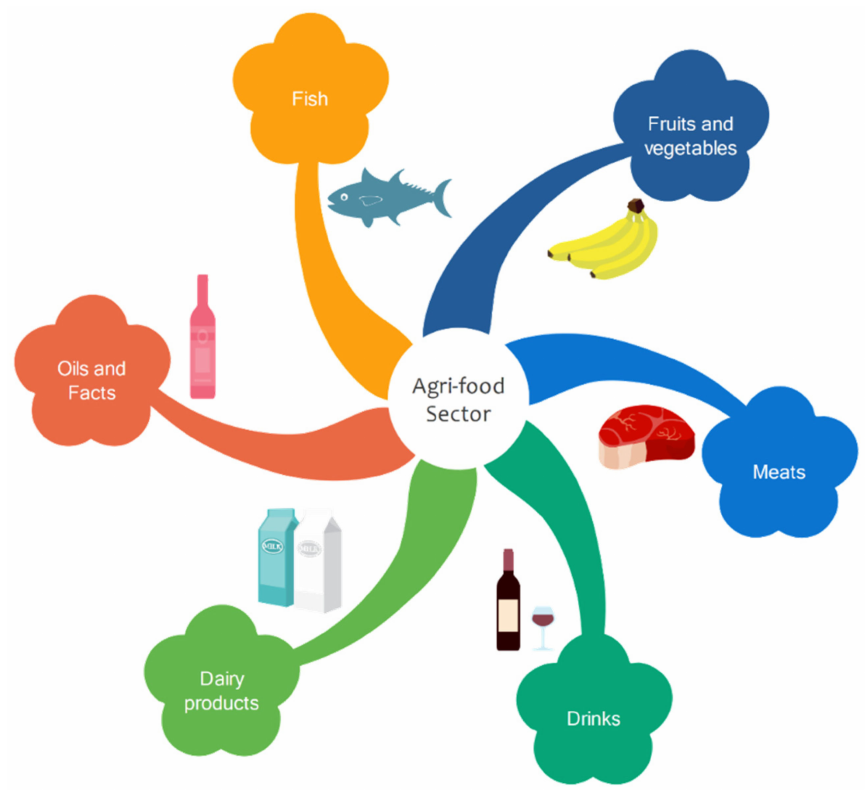
Figure 1. Different industries in the agri-food